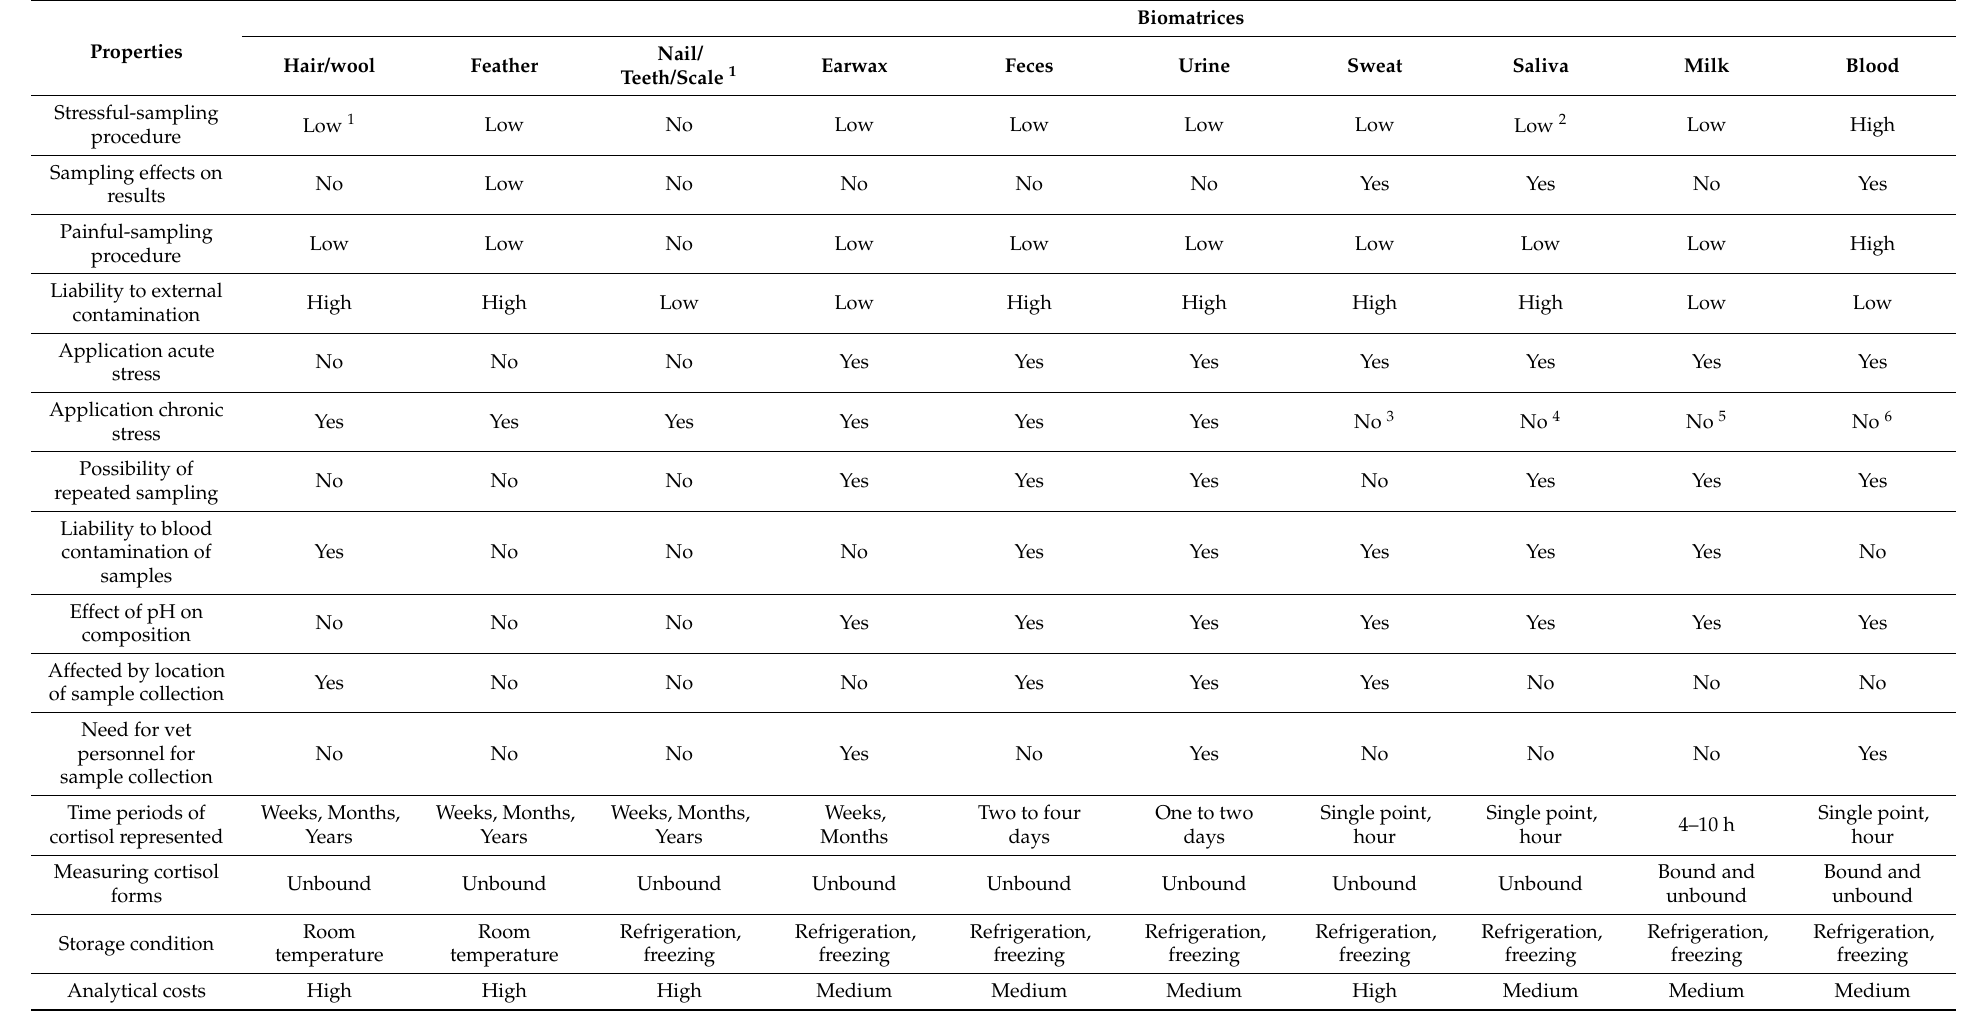
Table 1. Properties of hair matrix in comparison to other biological matrices where cortisol/corticosterone can be analyzed